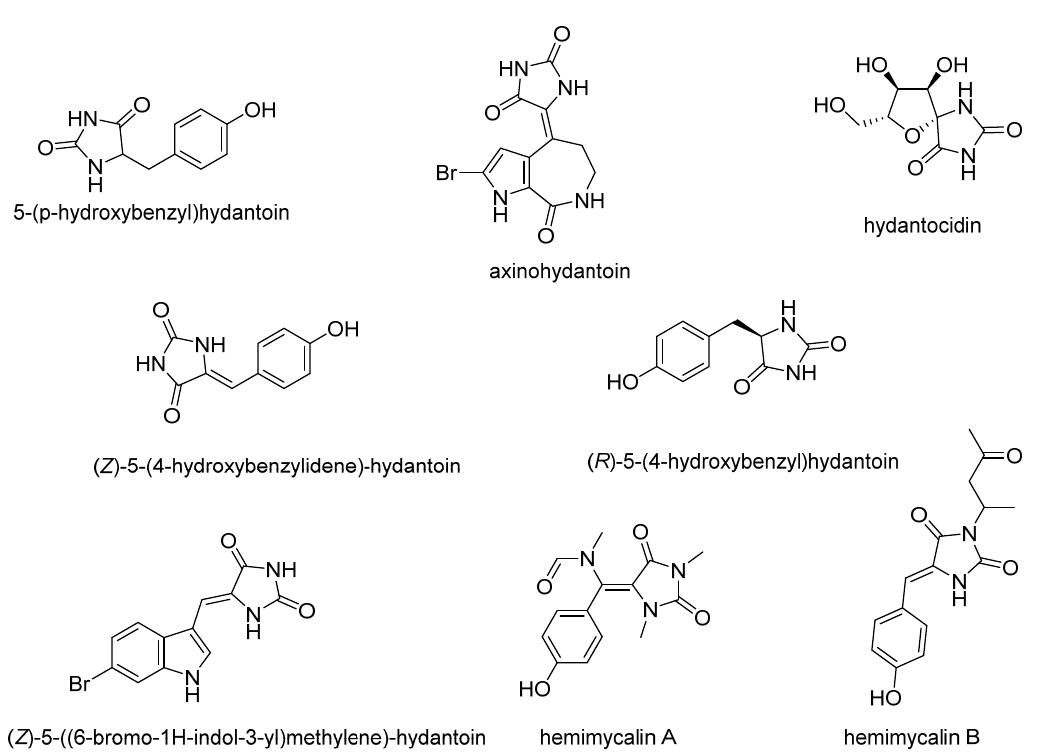
Figure 1. Naturally occurring hydantoins.